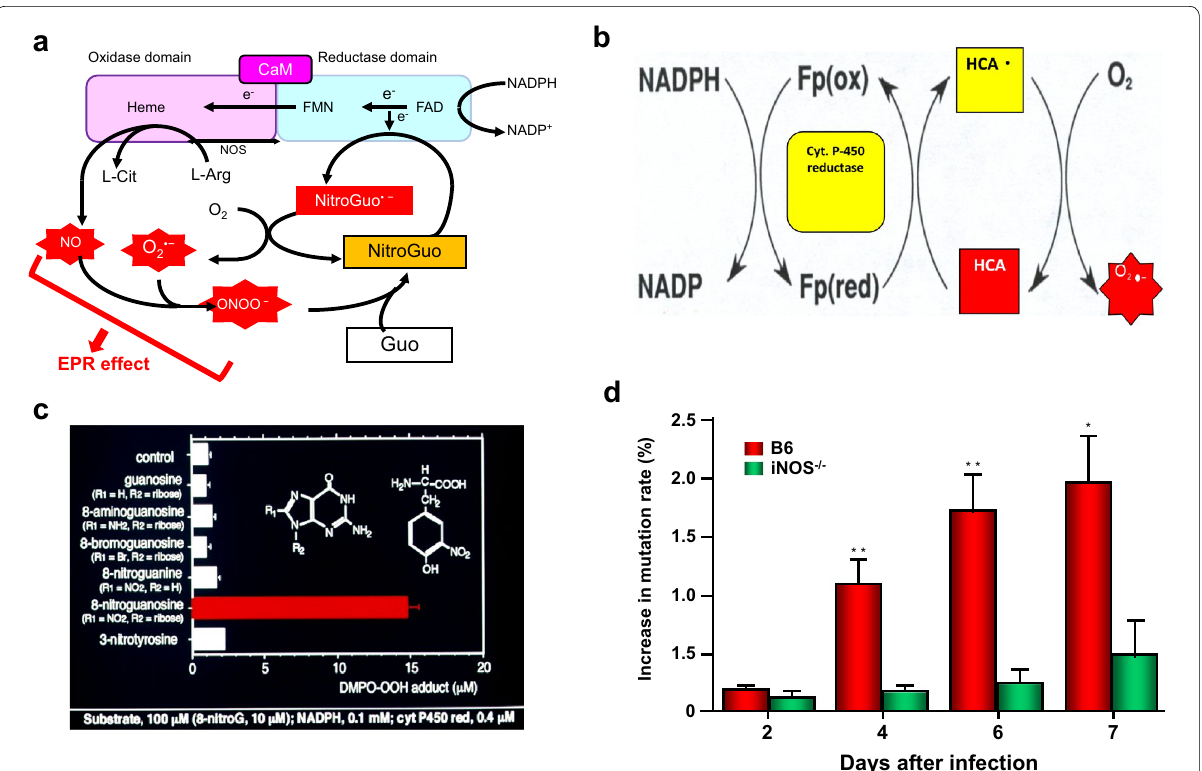
Fig. 1 Generation of free radicals by infection and by heterocyclic amine (HCA), and generation of nitrated bases and mutation in Sendai virus via NO. Pathways a , c and d are involved in infection-induced inflamed tissue involving induction of inducible form of nitric oxide synthase (iNOS), and subsequently generation of nitric oxide (NO) and superoxide (O 2 ·− ) and then peroxynitrite (ONOO − ), which nitrated guanine ( and 8-nitroguanosine (NitroGuo), as substrates of NOS or cytochrome c reductase, thereby generation of O 2 ·− . The total system progressively pro- duces O 2 ·− , with stoichiometry of greater than 1:1 [51, 100, 108]. b Generation of O 2 ·− from heterocyclic amine (HCA) in the presence of cytochrome (Cyt) P450 reductase and NADPH, resulting in DNA damage, cleavage and mutation. c NADPH cytochrome P450 reductase would generates O 2 ·− most effectively from nitroguanosine among other base-modified derivatives [57–61]. d Shows the NO dependence of viral mutation. *, **, significant changes in % viral mutations in B6 mice, in comparison with iNOS knockout mice by time. ** statistical significance (< 0.01). See